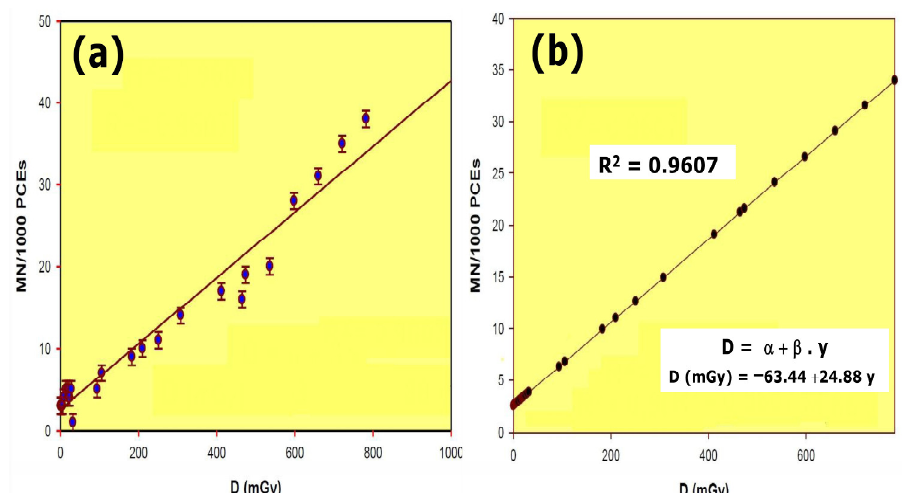
Figure 2. Dose–response relationship of radiation induced micronuclei in mouse: ( a ) results obtained; ( b ) linear regression and R squared value calculated from the results obtained.